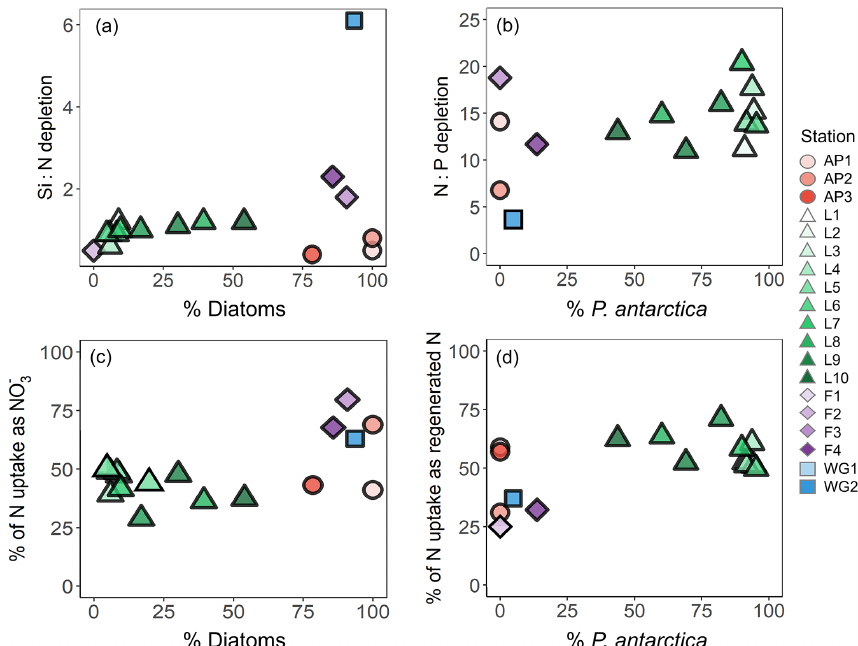
Figure 11. Scatterplots of (a) the Si : N depletion ratio (i.e. Si ( OH ) 4 to total N depletion) versus relative diatom abundance, (b) N : P depletion ratio (i.e. total N to PO 43 − depletion) versus relative P. antarctica abundance, (c) the proportion of total N (i.e. NO 3 − + NH 4 + + urea) assimilated as NO 3 − versus relative diatom abundance, and (d) the proportion of total N assimilated as regenerated N (i.e. NH 4 + + urea) versus relative P. antarctica abundance at each